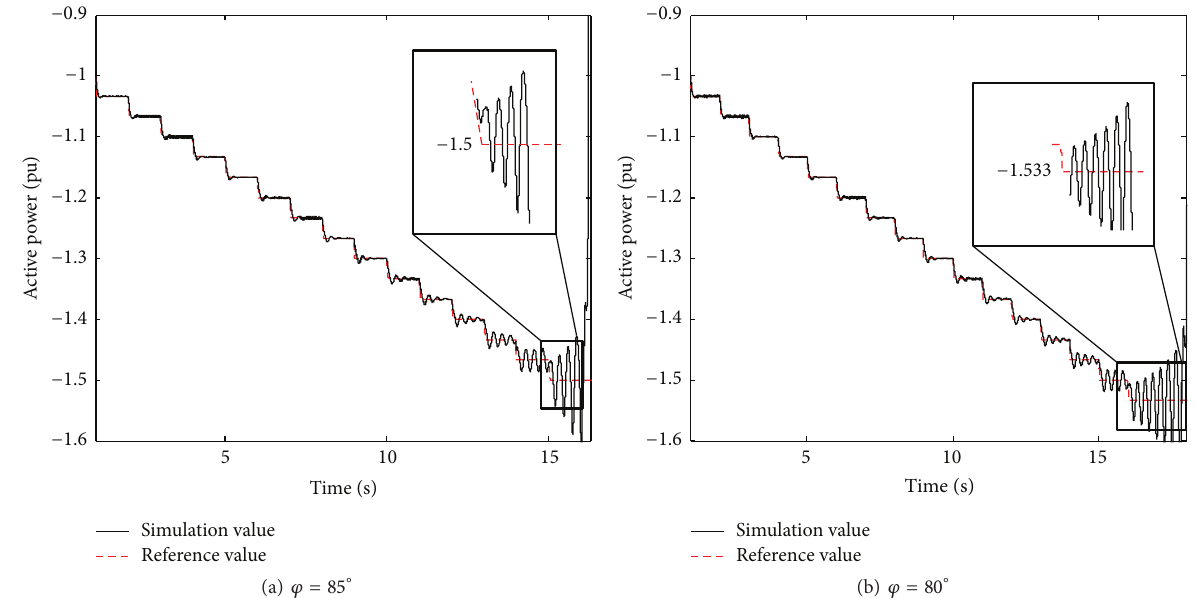
Figure 10: Maximum power transmission with different impedance angles (inverting